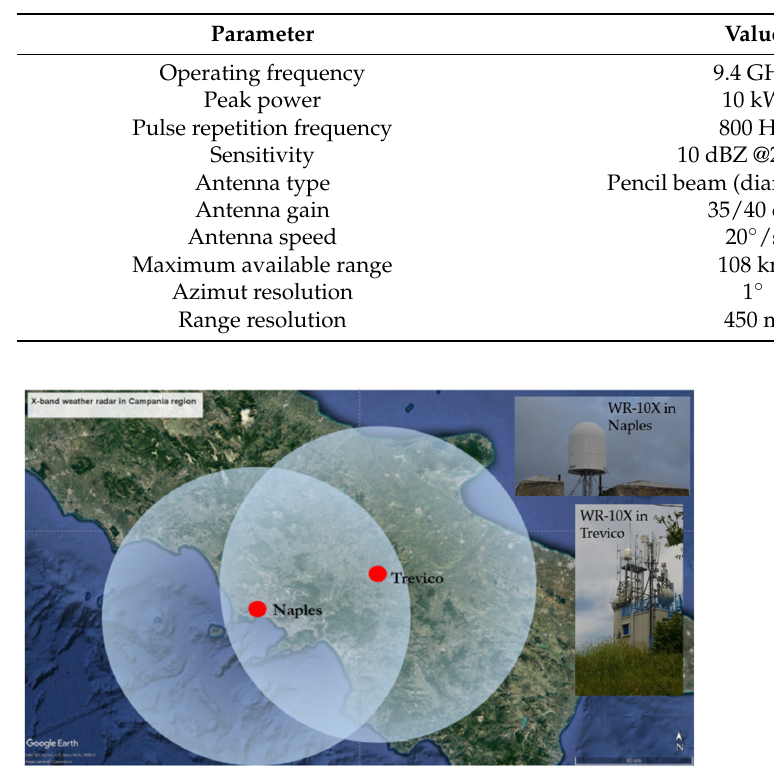
as follows. Both systems perform a complete scan every 10 min, with synchronized start times. For the Naples radar, the atmosphere is scanned with ten elevations (1, 2, 3, 4, 5, 7.5, 10, 12.5, 15 and 20°), with a range resolution of 450 m and an azimuth resolution of 1.0